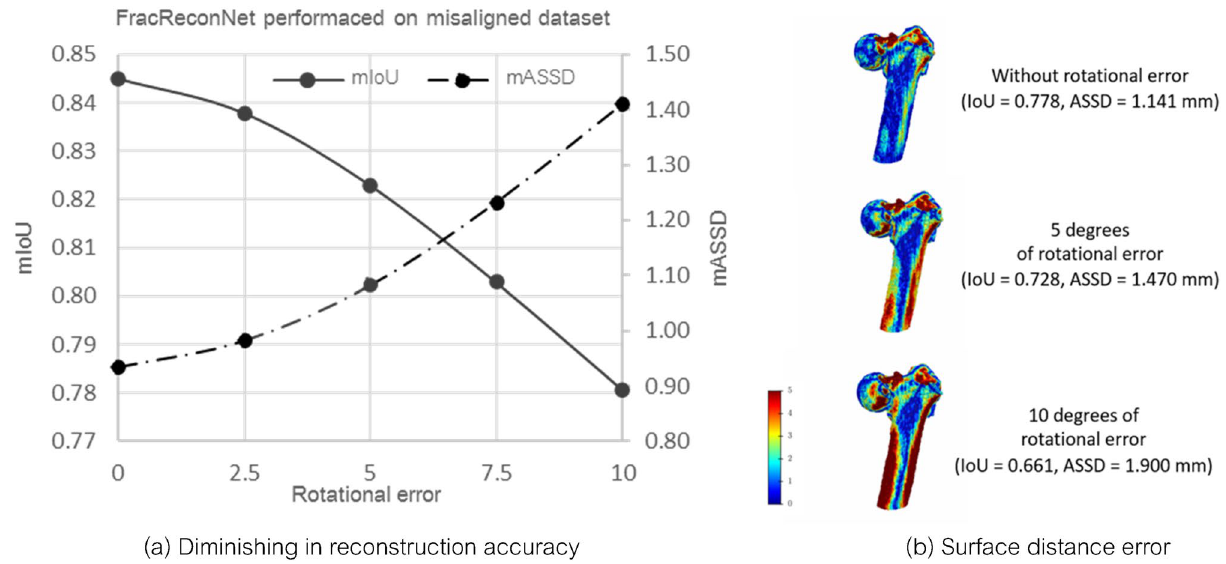
Figure 7. Effect of rotational error between two radiographs on reconstruction